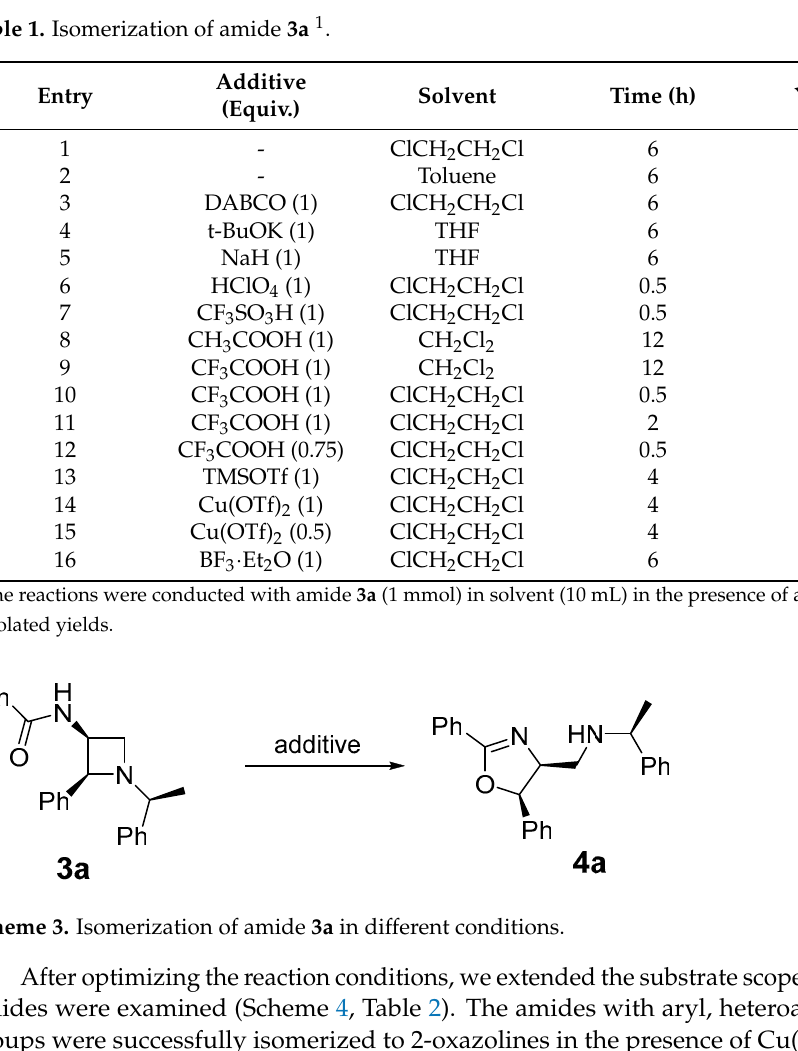
Table 1. Isomerization of amide 3a 1